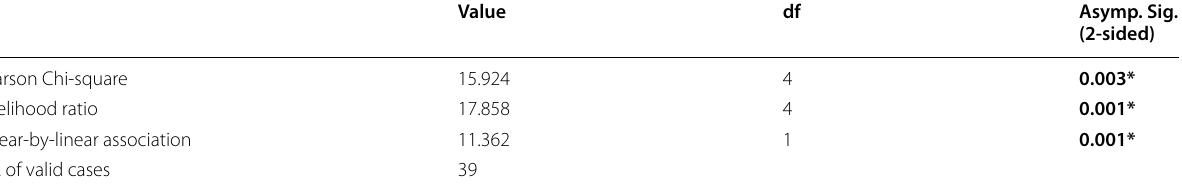
Df. degrees of freedom. Asymp. Sig. asymptotic